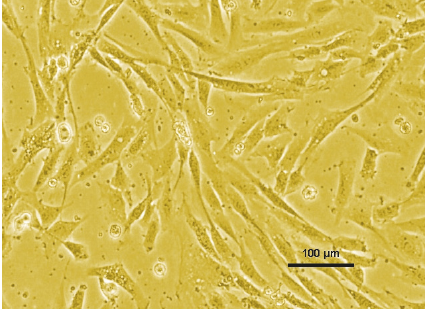
Figure 8: Fibroblast proliferation on chitosan/TiO 2 scaffold.